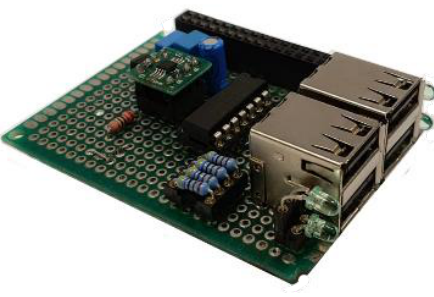
Figure 4. Design of the conditioning and data conversion board.